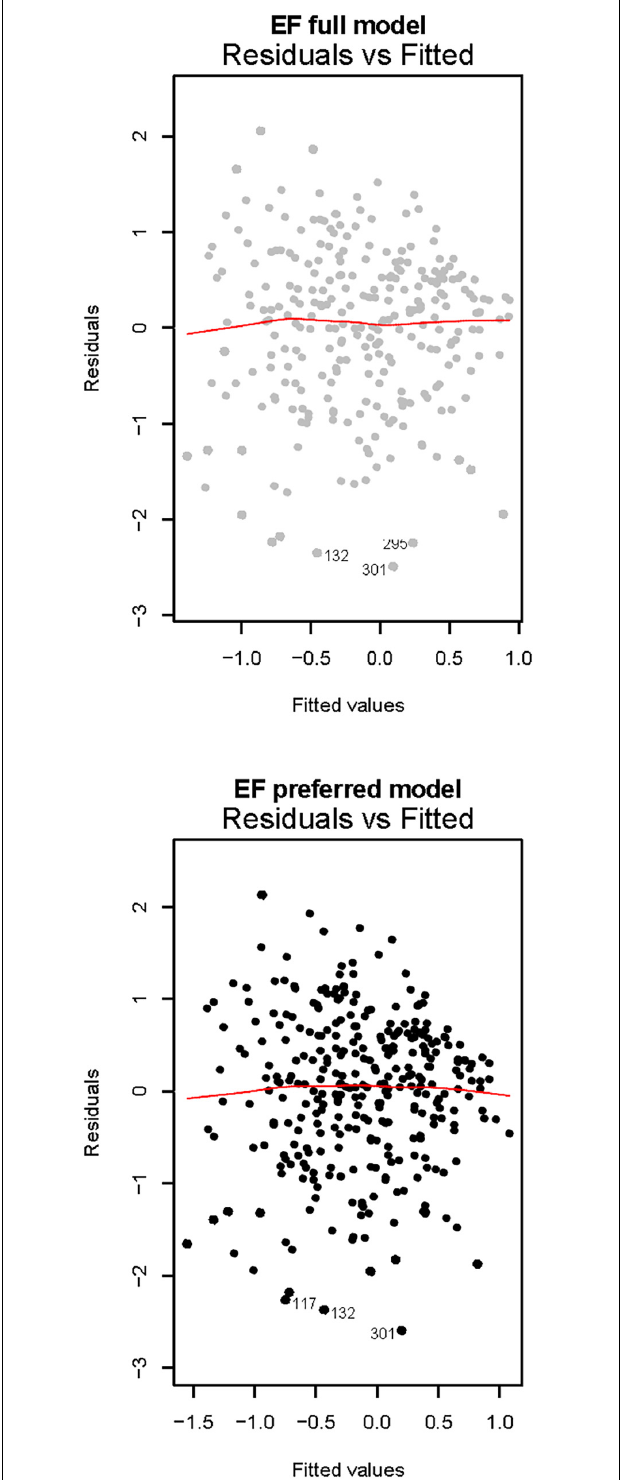
FIGURE 4 | Residuals versus fitted plots of EF regression models. The full model for EF included all predictors and accounted for 26% of EF score variance, whereas the preferred model included age, sex, parental education, and age at preschool enrollment, and explained 29% of EF score